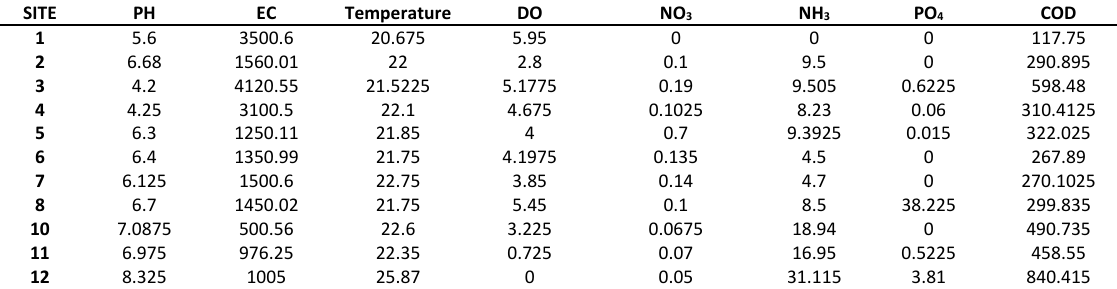
Table 2: Averages of Physico‐chemical water variables at sites on the Mukuvisi River during the wet season SITE PH